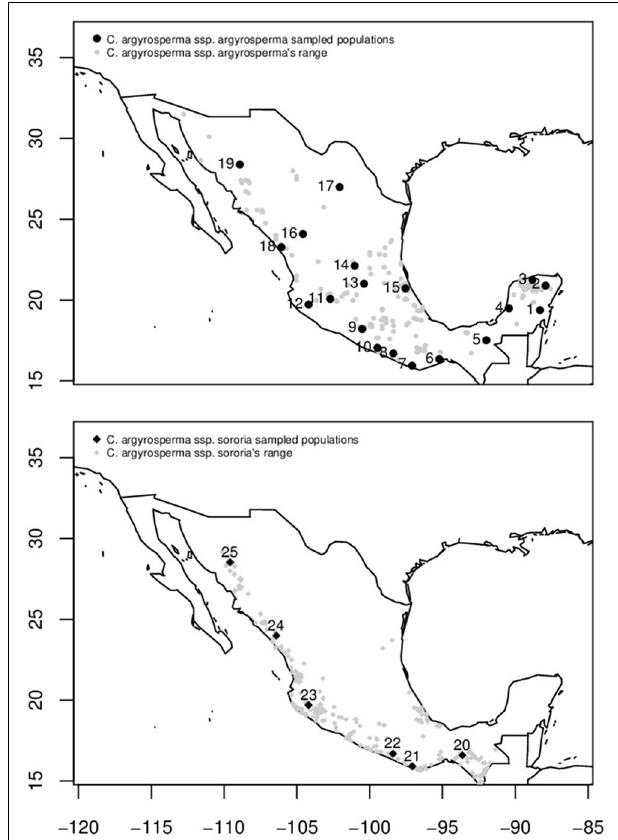
FIGURE 2 | Distribution area in Mexico (gray symbols) and sampled populations of C. argyrosperma ssp. argyrosperma ( Top , black points) and C. argyrosperma ssp. sororia ( Bottom, black diamonds). Population ID is shown in Table 1